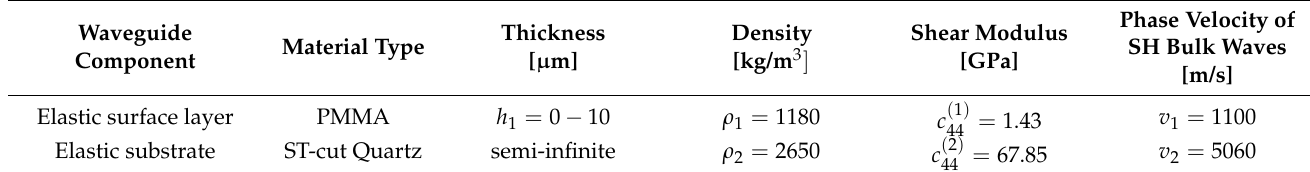
Table 1. Material and geometrical parameters of the Love wave waveguide.